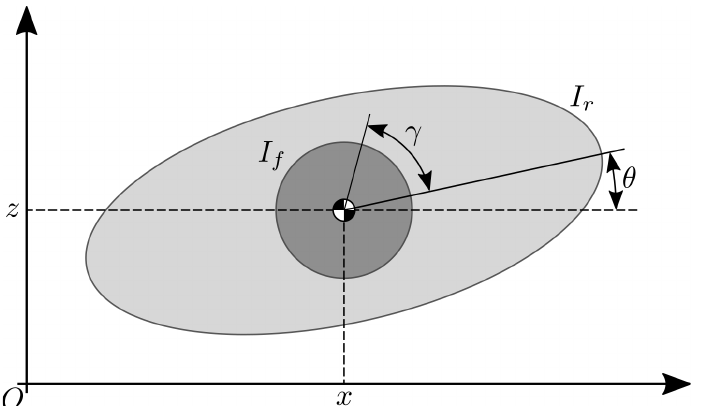
Figure 2. Schematic representation of the Elroy’s Beanie model used for the preliminary analysis of the pitch